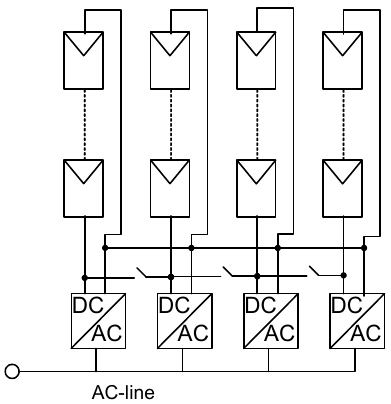
Figure 12. Illustration of the TEAM concept [26].